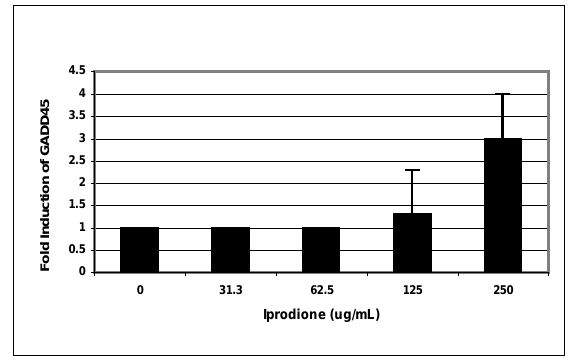
Fig. 8: Fold induction of GADD45 in HepG